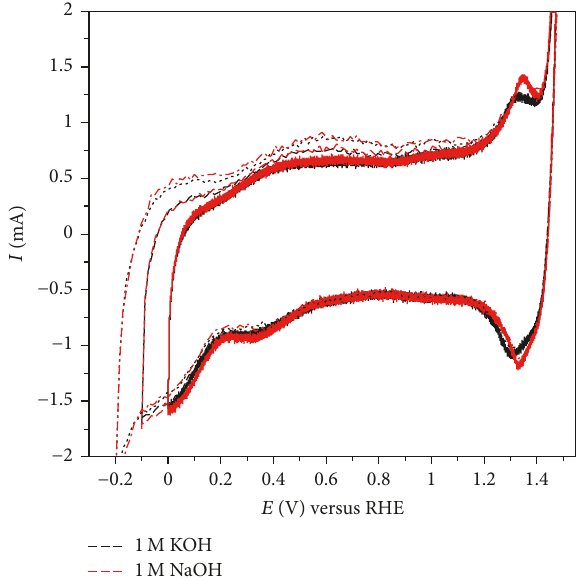
Figure 4: Cyclic voltammograms of alkali hydroxide solutions (red: 1-molar KOH; black: 1-molar NaOH). Impact of an extended potential window (solid lines: 0 to 1.5 V; dashed lines: − 0.1 and − 0.2 to 1.5 V). Scan rate: 100mV/s.